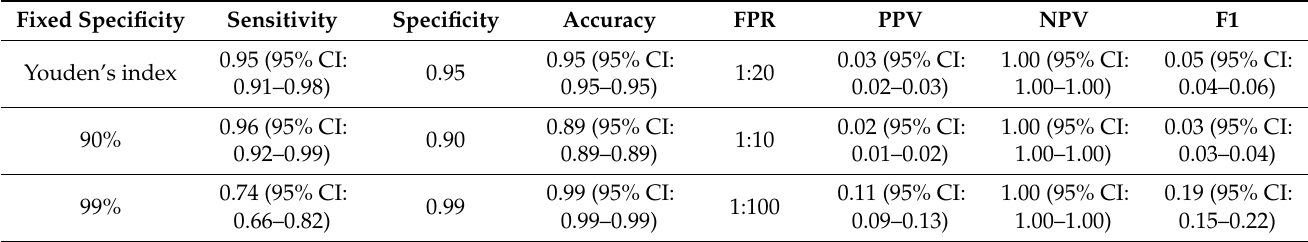
Table 4. Metrics of the LR-tf-idf—gradient boosting ensemble model for predicting in-hospital mortality within 48 h.